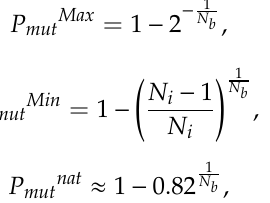
Figure 2. Integer population size against total bits for total bits selection.